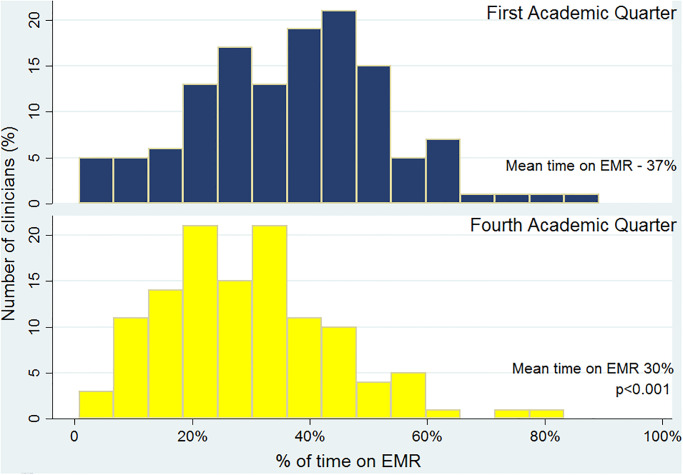
Percentage of time on EMR for all clinicians.